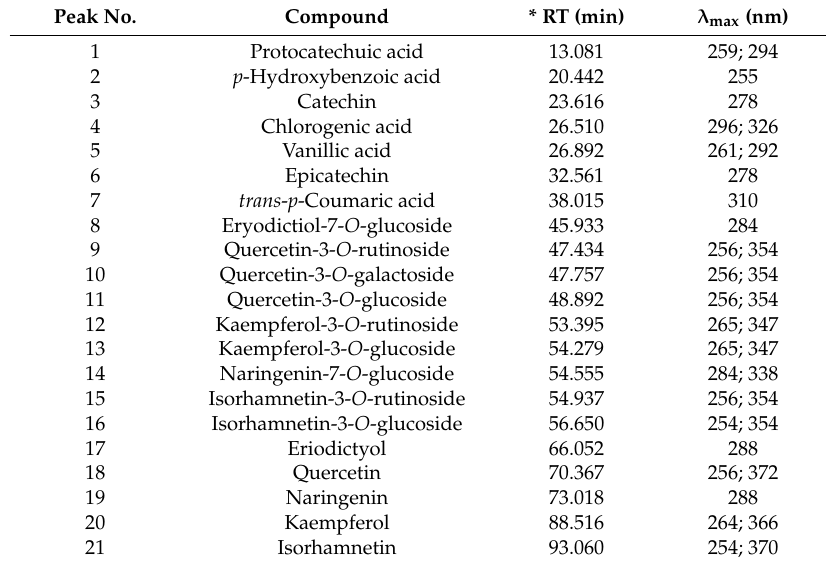
Table 2. Polyphenolic compounds identified in natural (NS) and blanched (BS) almond skins. Peak No.